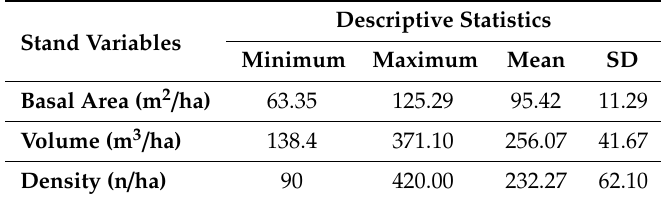
Table 2. Mean, minimum, maximum, and standard deviation of the main forest variables for all plots in the study